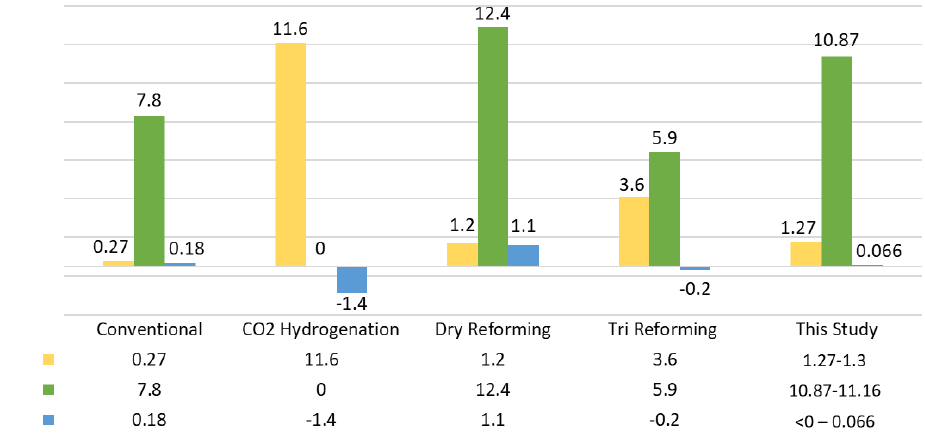
Figure 12. Main process characteristics for different methanol production